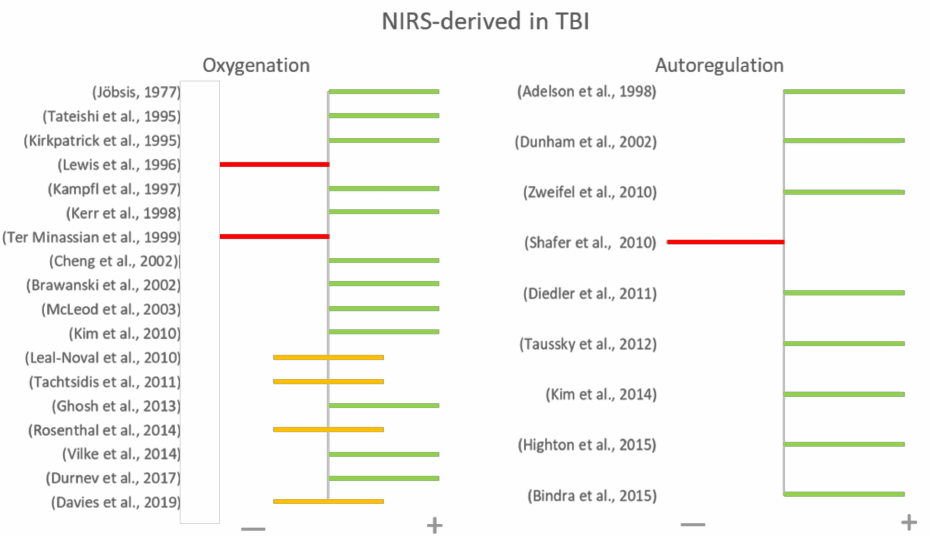
Figure 15. Main conclusions of NIRS-derived monitoring in TBI. Each author concluded with a positive (green) or negative (red) statements. In a few cases, authors reported positive results with some limitations